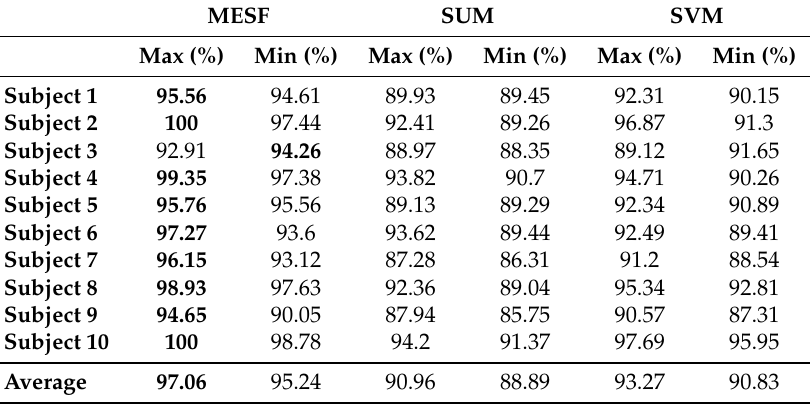
Table 3. MESF, SUM, and SVM performance using min and max pooling. Bold numbers represent the highest accuracy achieved for each subject using different